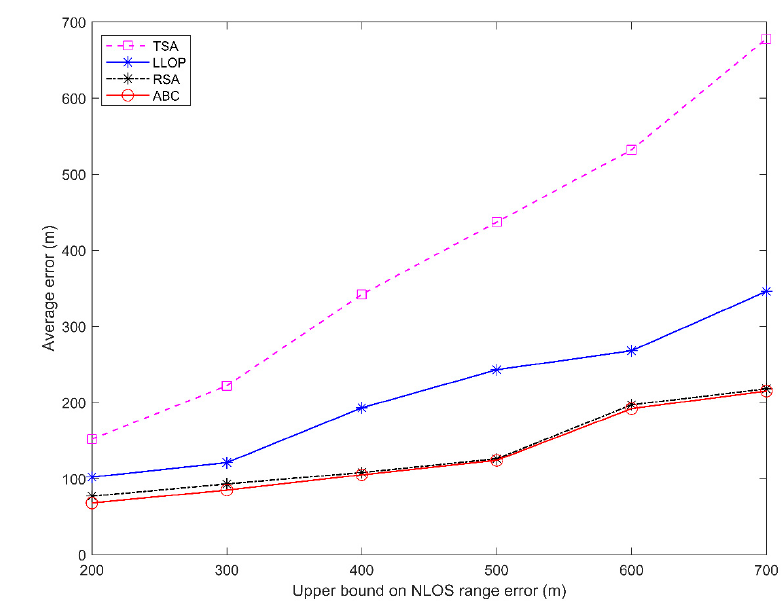
Figure 8. Average location error versus the upper bound of non-line-of-sight (NLOS) errors.